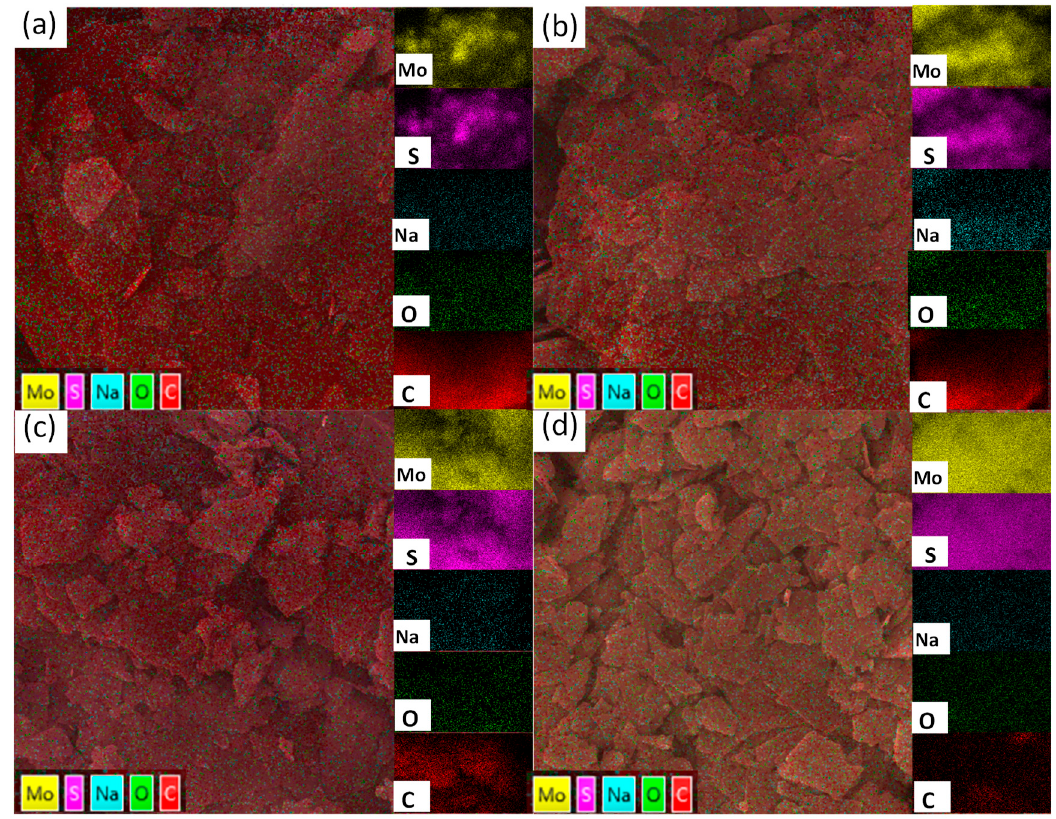
Figure 3. EDS images: ( a ) MoS 2 /graphite (20%:80%); ( b ) MoS 2 /graphite (40%:60%); ( c ) MoS 2 /graphite (60%:40%); ( d ) MoS 2 /graphite